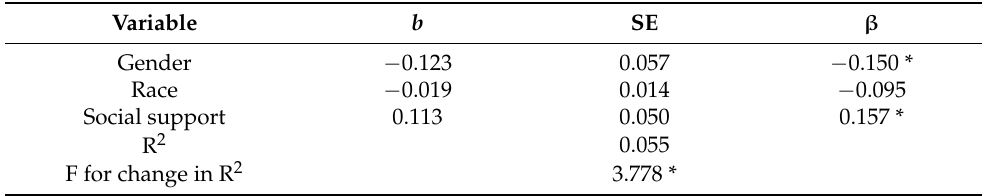
Table 4. Summary of regression analyses for the association between social support and future